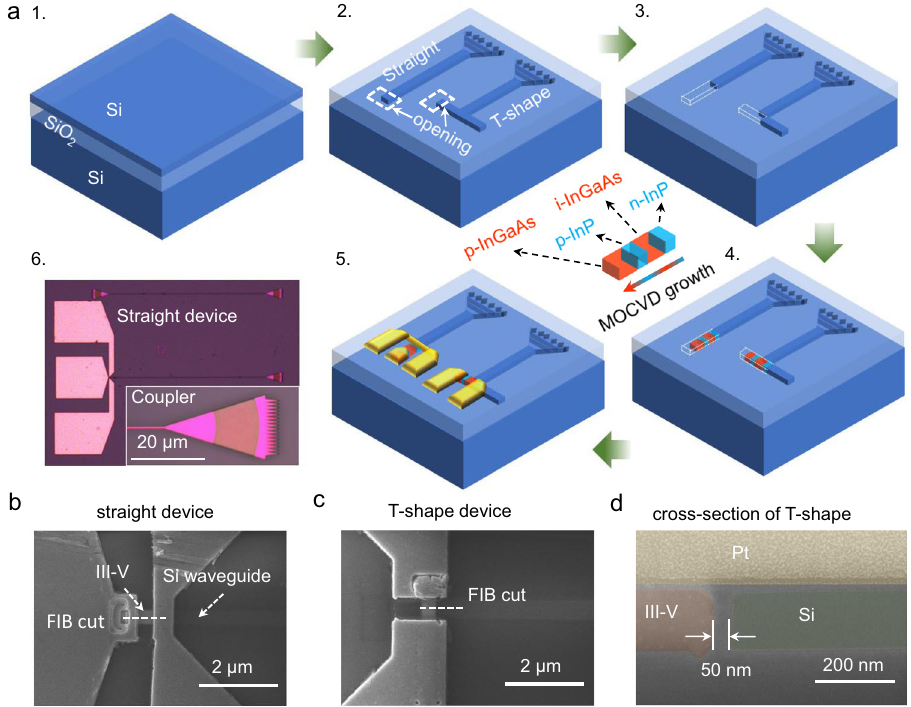
Fig. 1 Template-assisted selective epitaxy fabrication process. a Simpli fi ed schematic of the fabrication process: 1. SOI wafer. 2. Patterned top Si layer and openings (300 nm * 600 nm). 3. Partial etch-back of Si to form hollow SiO 2 template with a Si seed. 4. Metal-organic chemical vapor deposition (MOCVD) of heterostructure p-i-n device, the arrow in the inset shows the growth direction. 5. Ni/Au contacts on the nanostructure. 6. Optical microscope image of a straight device and the coupler in the inset. b Top view scanning electron microscope (SEM) image of a straight device, showing the focused ion beam (FIB) cut line. c Top view SEM of a T-shape device showing the FIB cut line. d Cross-section false-colored SEM image of a T-shape device showing the ~50 nm wide oxide- fi lled gap separating the Si waveguide and the III – V active